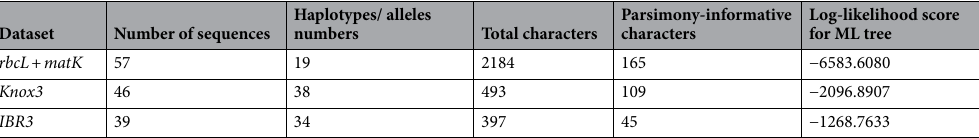
Table 2. The characters of DNA datasets of Pteris fauriei